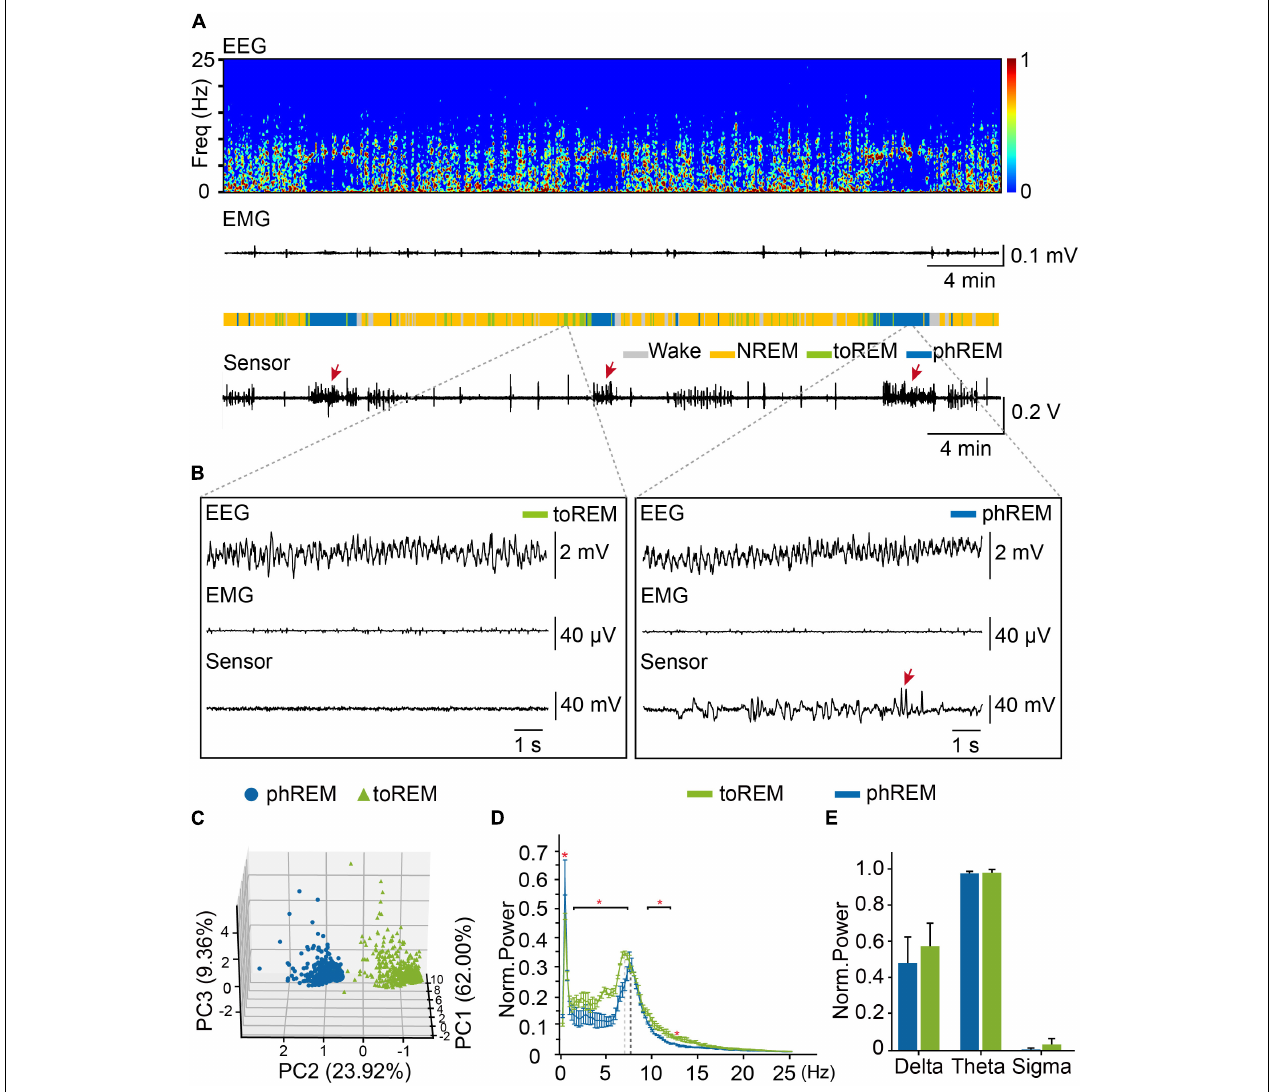
FIGURE 5 | Tonic REM and phasic REM sleep in mice. (A) Representative data showed EEG power spectrogram, electromyogram amplitude, brain states, and eye movements curve. toREM, tonic REM. phREM, phasic REM. Sleep pattern of representative data: Wake, 4.3 min, NREM, 24.8 min, tonic REM, 4.3 min, phasic REM, 6.7 min. Bursts of eye movement were indicated by arrows. (B) Example of EEG, EMG, and eye movements raw traces during tonic REM (left) and phasic REM (right) . Bursts of eye movement were indicated by arrows. (C) PCA analysis for tonic and phasic REM. Blue dots, phasic REM. Green triangles, tonic REM. (D) Averaged power spectra during tonic REM and phasic REM. The red asterisk indicated statistically significant (two-way repeated-measures ANOVA followed by post hoc comparison with Tukey’s correction). Bin limits: 0.25 Hz. (E) Average power of delta (0.65–4 Hz), theta (6–10 Hz), sigma (12–14 Hz) oscillation during tonic REM and phasic REM (Norm, normalization) ( n = 3, student’s t -test). Data are expressed as mean ± SEM, * p <